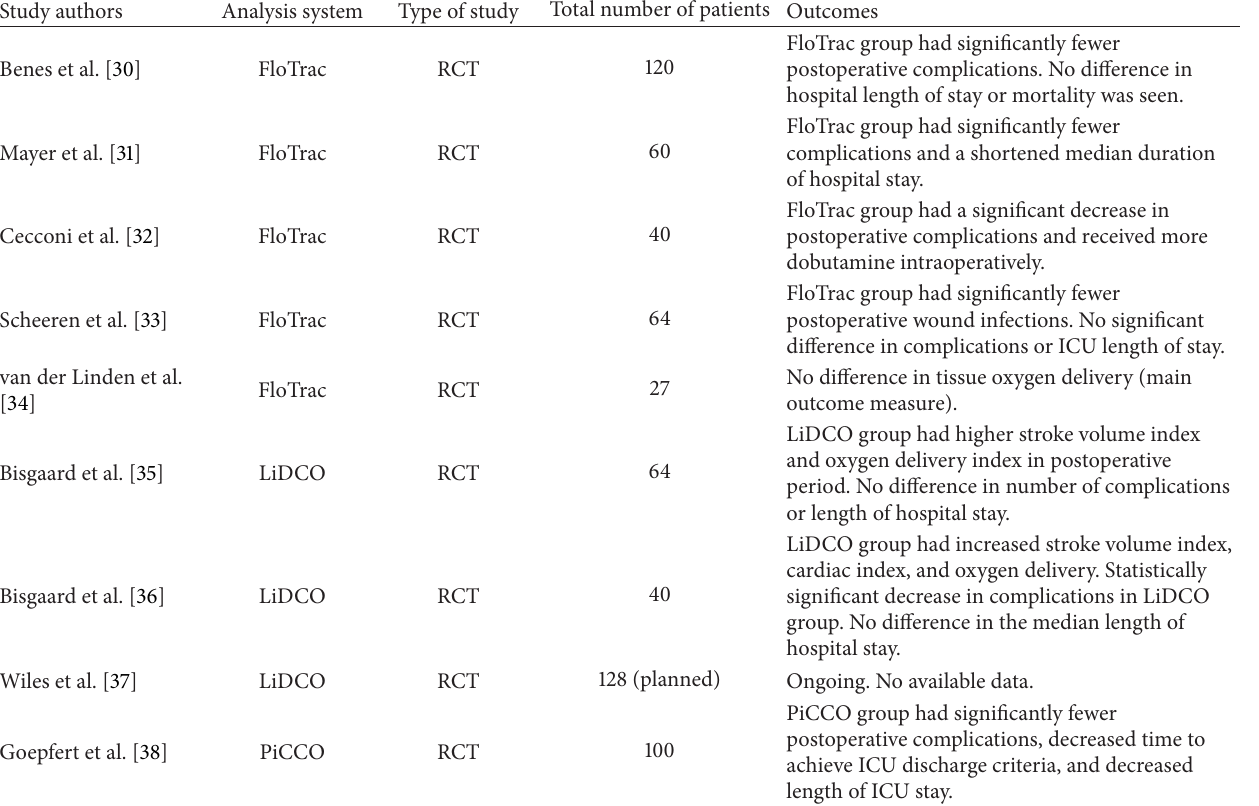
Table 2: Studies using IGDT with arterial waveform analysis